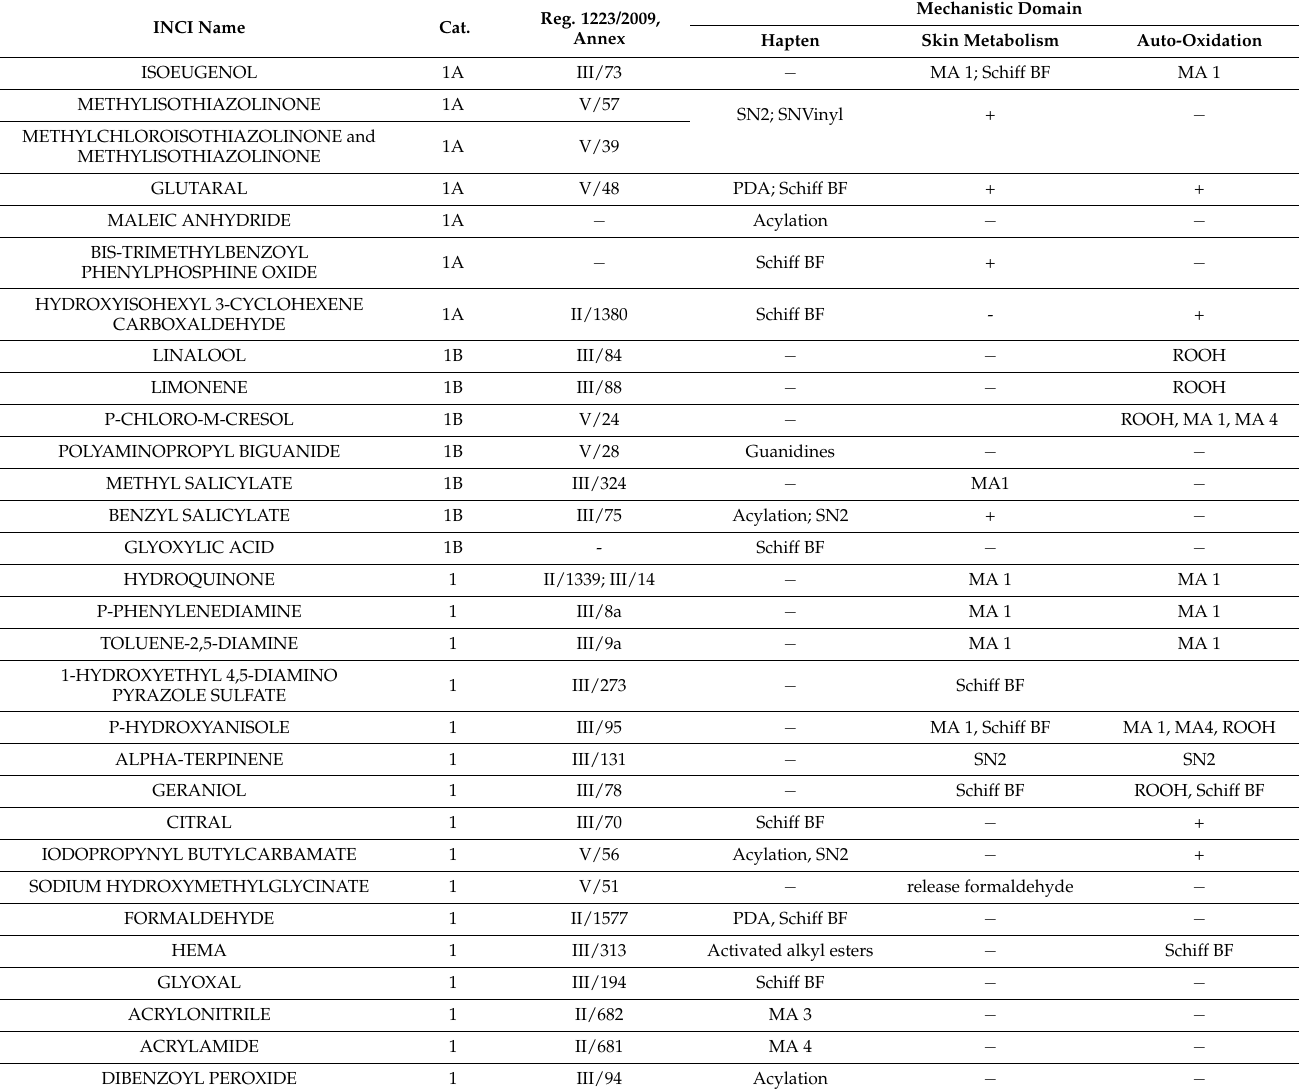
Table 6. Selected regulated cosmetics skin sensitisers along with their mechanistic